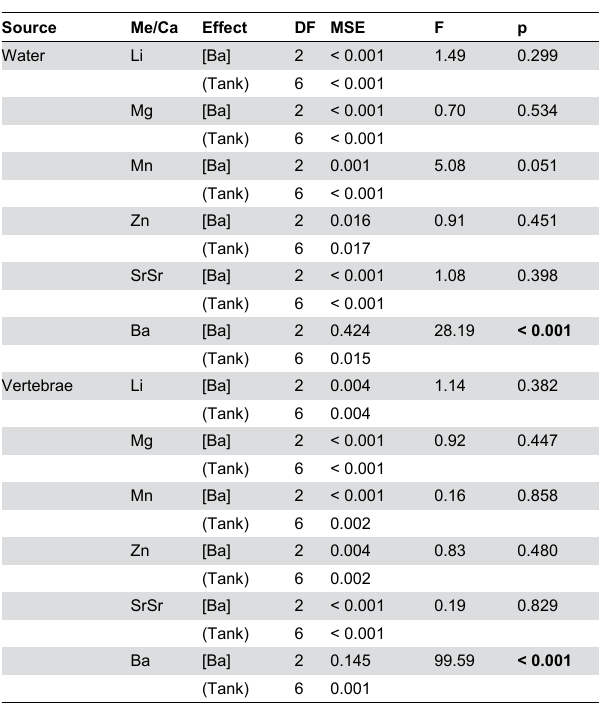
Table 5. Univariate results from multivariate analysis of variance tests to evaluate the effect of barium concentration ([Ba]; 1x, 3x, and 6x local ambient values) on dissolved element to calcium ratios in water and vertebral element to calcium ratios among